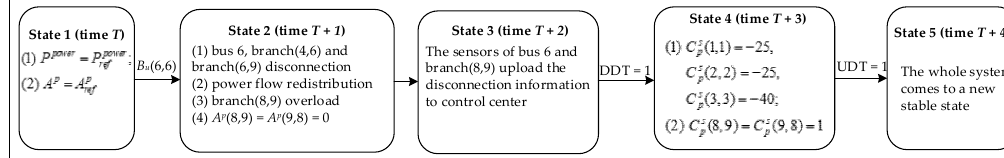
Table 2. The power flow transferring under bus fault (MW). Figure 4. The new stable state of CPPS after the branch fault.